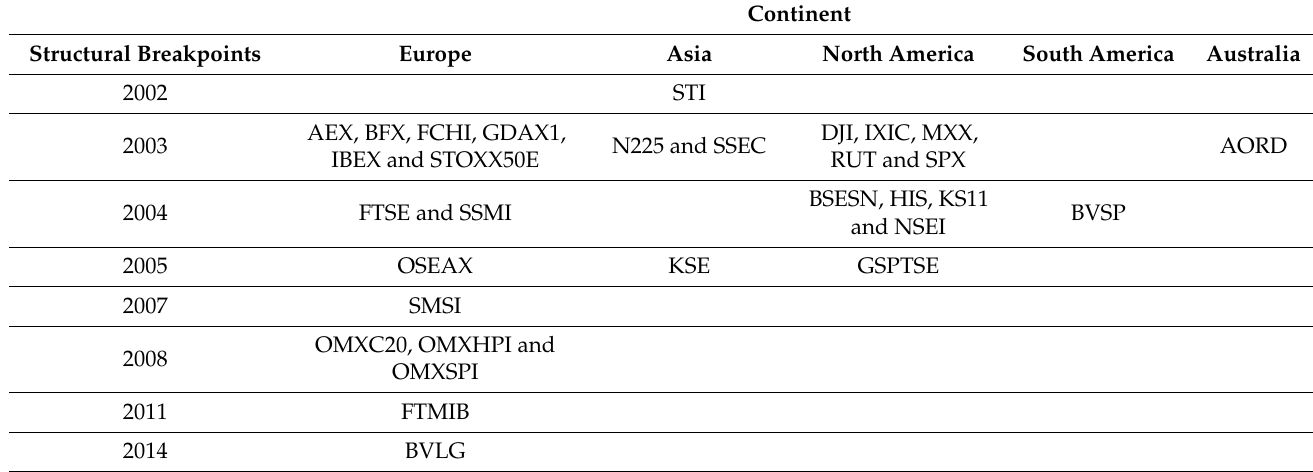
Table 1. Structural